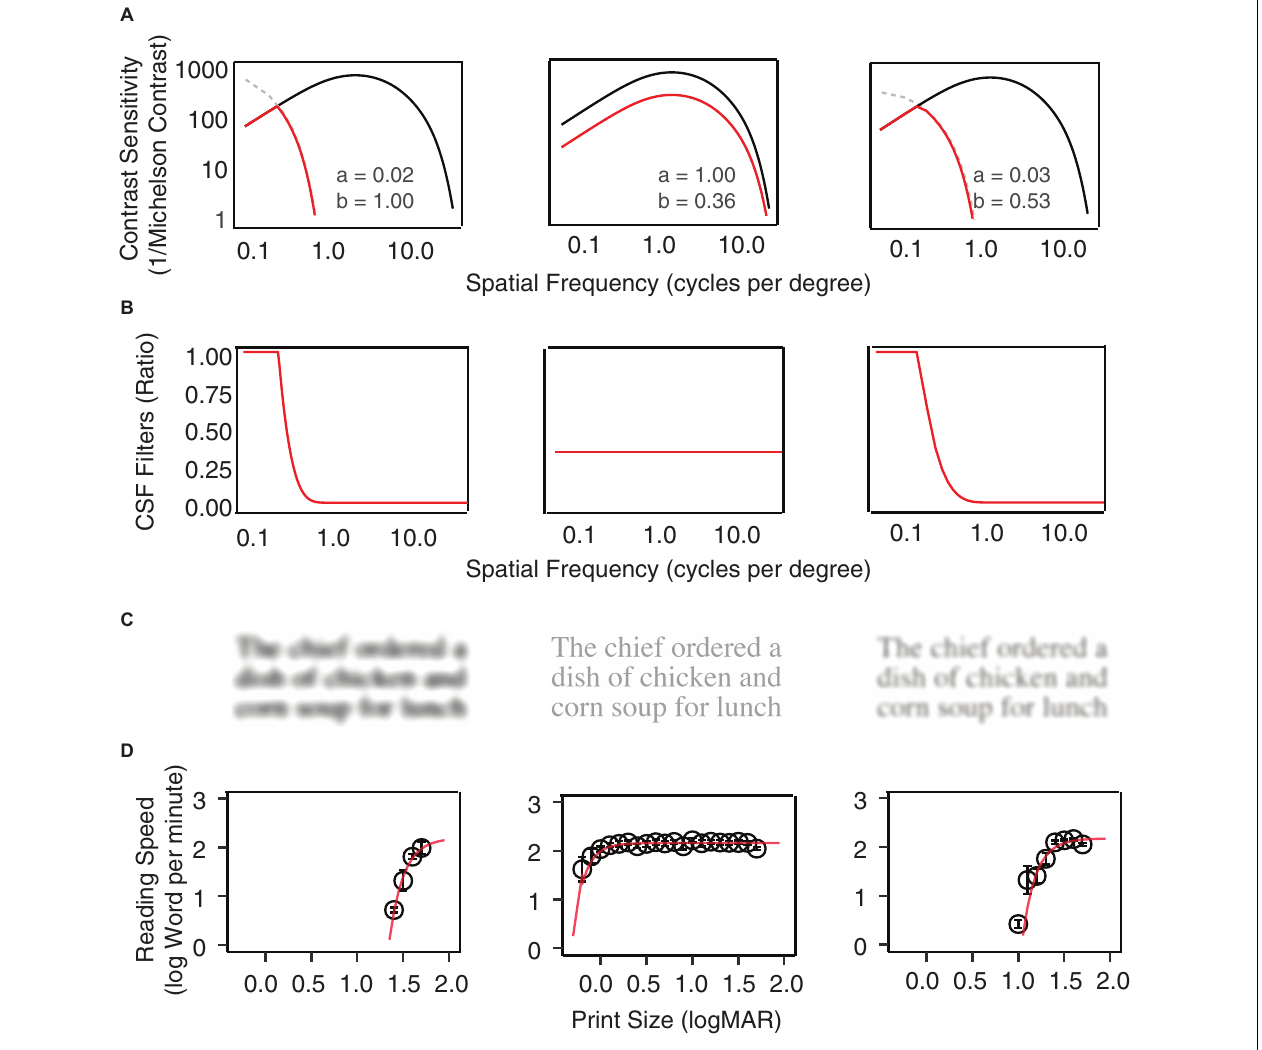
FIGURE 1 | Examples of CSF filters. (A) Normal vision CSFs are represented with black curves, and the low vision CSFs are represented by red curves with horizontal and vertical scaling of the normal CSF. From left to right, the plots show examples of horizontal scaling, vertical scaling, and horizontal-plus-vertical scaling conditions. The scaling factors are listed in each plot. (B) The CSF filters are defined by the ratio between the low vision and normal vision CSF in (A) . (C) A MNREAD sentence filtered by the three CSF filters. (D) Reading speed (log word per minute) as a function of print size under the three conditions.